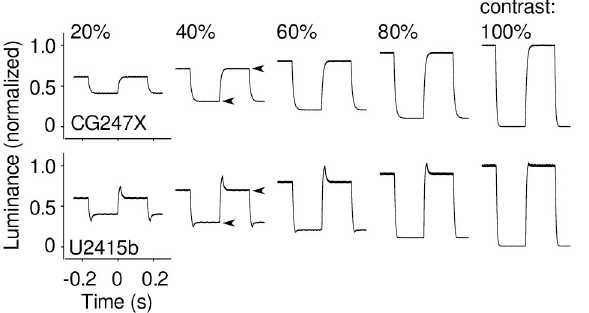
Fig 6. Example responses of the CG247X (upper) and the U2415b (lower) to mean-modulated flicker. Flicker period = 20 frames (333.3 ms), and contrast = 20 to 100% in increments of 20 as marked. At 40% contrast, the arrowheads show examples of luminance step source and destination as used in the computation of response times (Fig 7). For each display, we normalized traces to the luminance step destination at 100% contrast. For the U2415b, over- and undershoot are readily apparent at low and moderate contrast. The CG247X, however, shows exponential rise and fall, regardless of contrast.